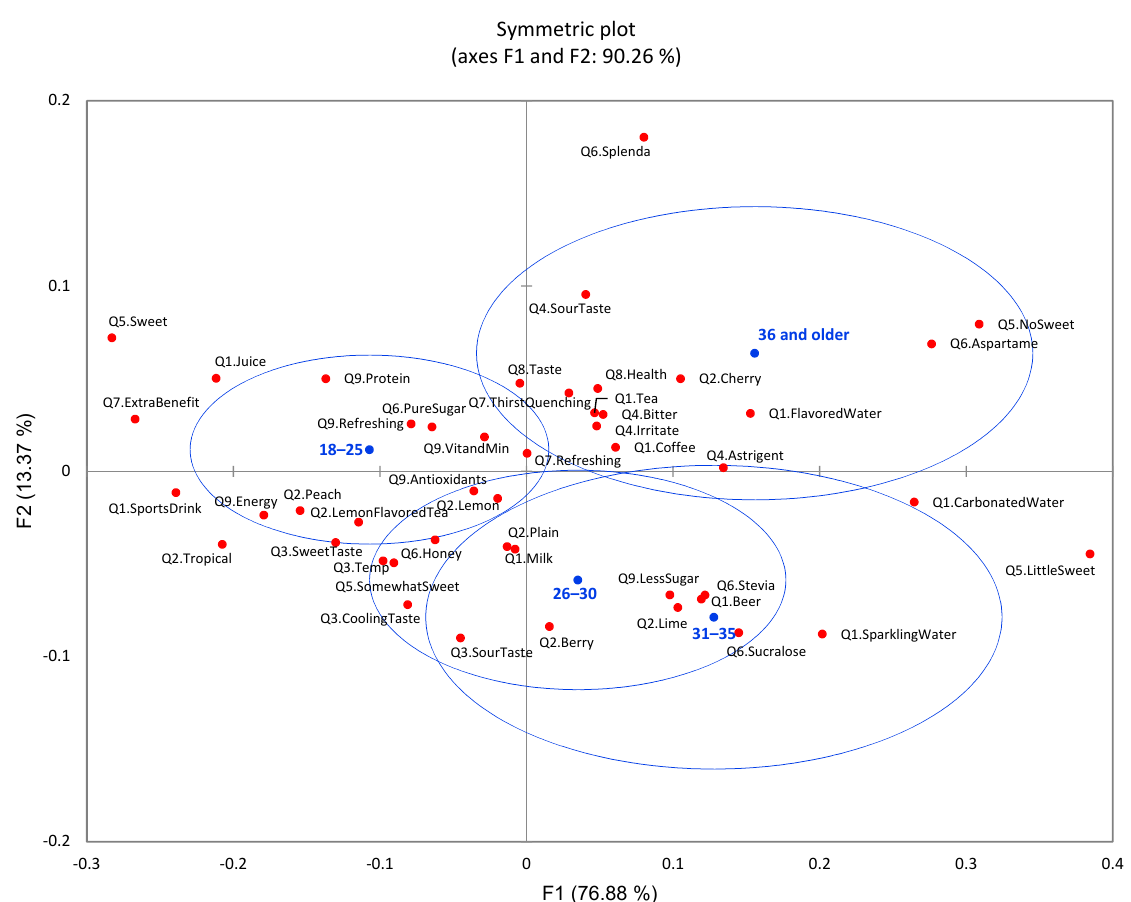
Figure 10. The first two dimensions of correspondence analysis (CA) symmetric plot using age (18–25, 26–30, 31–35, and 36 and older) as rows and all nine survey questions as columns ( n = 901) (4 rows × 54 columns). Confidence ellipses on the plot were automatically created by XLSTAT software based on CA with observed χ 2 = 317.89 and p < 0.0001.